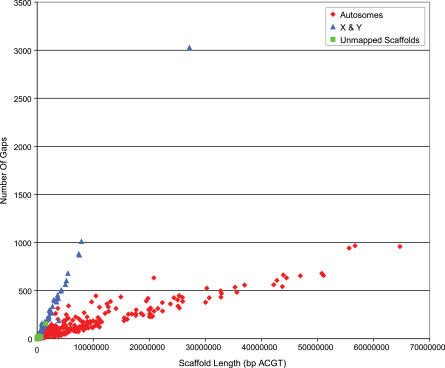
Sequencing Continuity Plot for the HuRef Autosomes Compared to HuRef X and Y ChromosomesNote that the autosomes have more contiguous sequence with fewer gaps compared to chromosomes X and Y, probably due to half the read depth compared to the autosomes and the presence of extensive sequence similarity between the sex chromosomes.